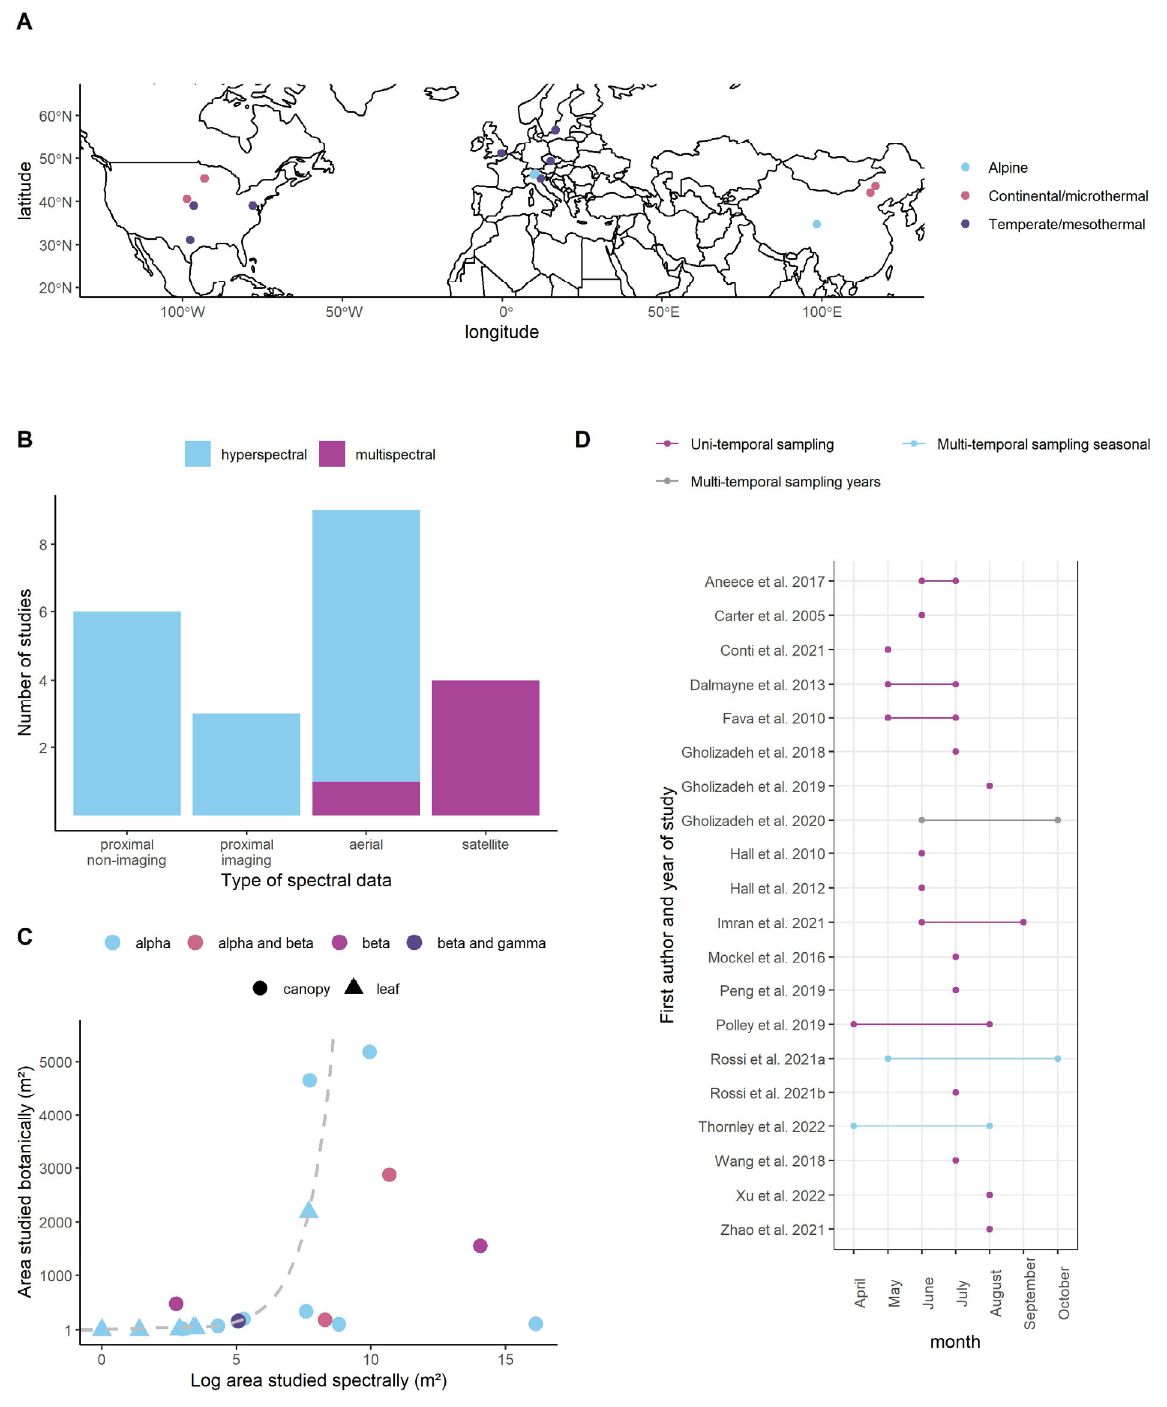
Figure 1. Literature search summary results. ( A ) The studies’ geographical locations, alongside their climate zone classifications. ( B ) The sensor type used and spectral resolution. ( C ) The area sampled botanically and spectrally and whether the data was collected at the leaf or canopy scale (the grey dashed line represents equal sampling efforts for both variables). ( D ) The time of year the sampling took place and whether the author examined the data multi- or uni-temporally and if in multiple years.